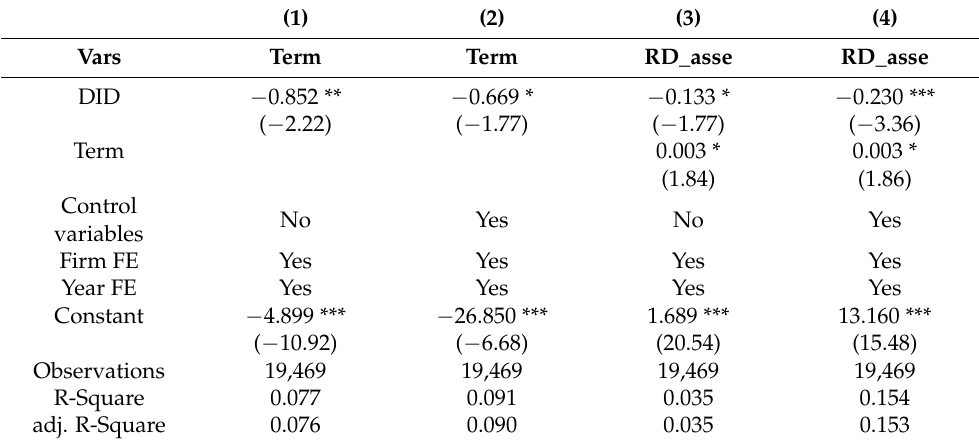
Table 6. Test for the mediating effect of loan term.